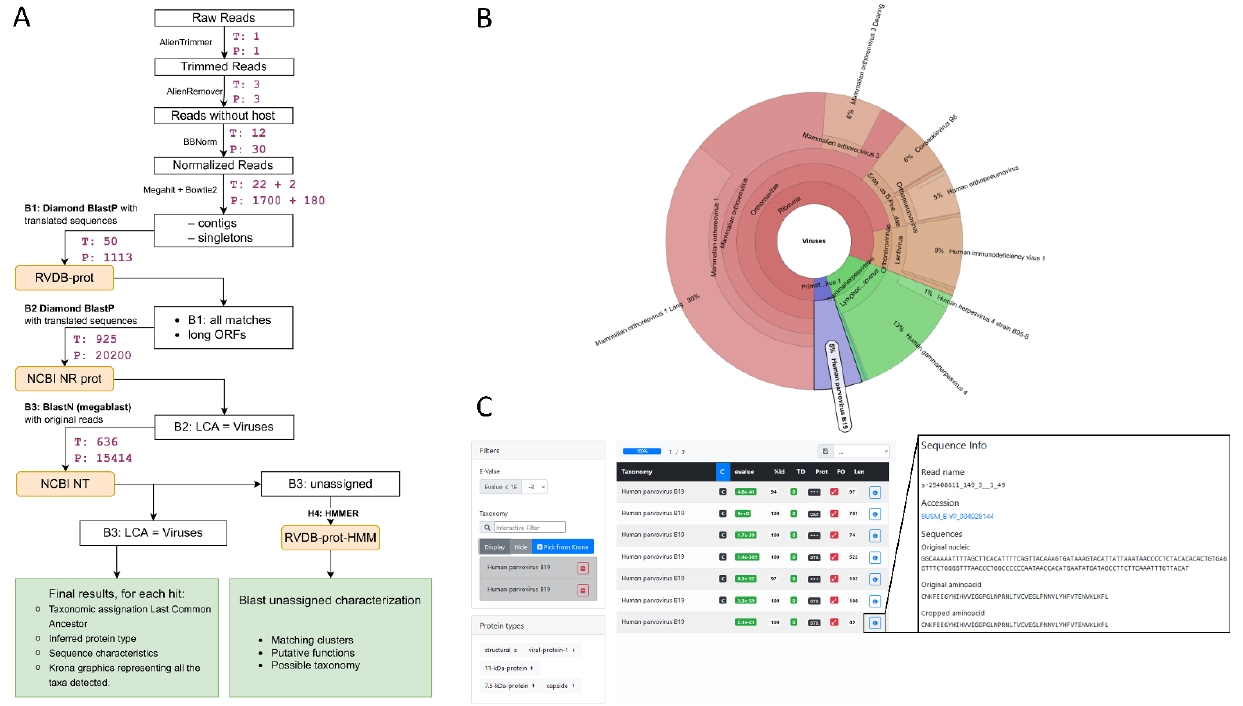
Figure 1. Microseek pipeline steps and output examples. ( A ) Step details of the pipeline. For each operation, software and database names are indicated. The times on the right represent the cumulated duration of each step (in minutes), respectively, for the Tissues (T) and Plasma (P) datasets and corresponding to spiked experiments at d1. For instance, for Plasma dataset, B1 step would take 1113 min if it was run with a single CPU as a unique chunk. ( B ) Example of a result browser webpage. The Parvovirus B19 taxon was selected from the Krona chart as an example. ( C ) Resulting list of hits of the Tissues dataset after filtering on Human Parvovirus B19 with e-value ≤ 10 − 3 , showing information such are the existence of contigs (C), e-value, %ID, length of the sequence and protein names. Information boxes associated to each hit give the nt and aa sequences and allow direct access to the corresponding NCBI